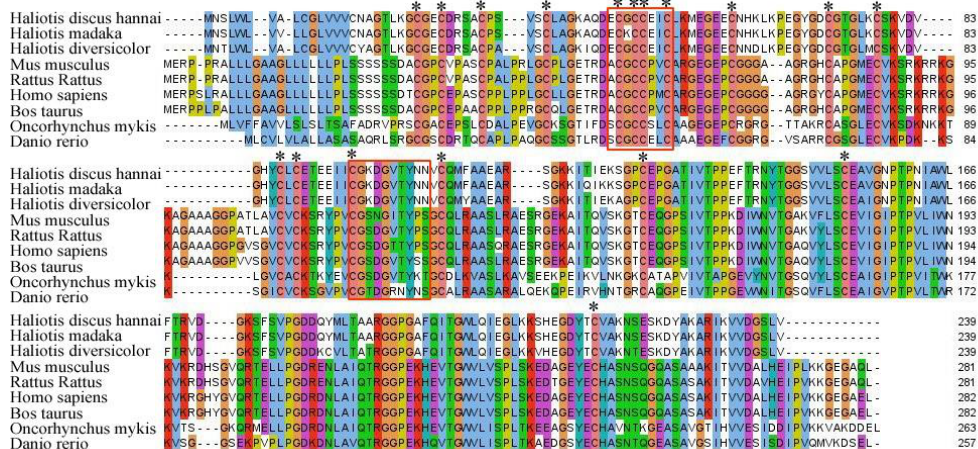
Figure 3. Multiple alignment of deduced amino acid sequences of Hdh IGFBP7 and IGFBP7 of other invertebrate and vertebrate species. Conserved cysteine residues are marked by asterisks. Highly conserved motifs are indicated by red boxes. Hdh, H. discus hannai ; Hm, H. madaka ; Hd, H. diversicolor ; Hs, Homo sapiens ; Mm, Mus musculus ; Bt, Bos taurus ; Dr, Danio rerio ; Om, Oncorhynchus mykiss ; Rr, Rattus rattus .